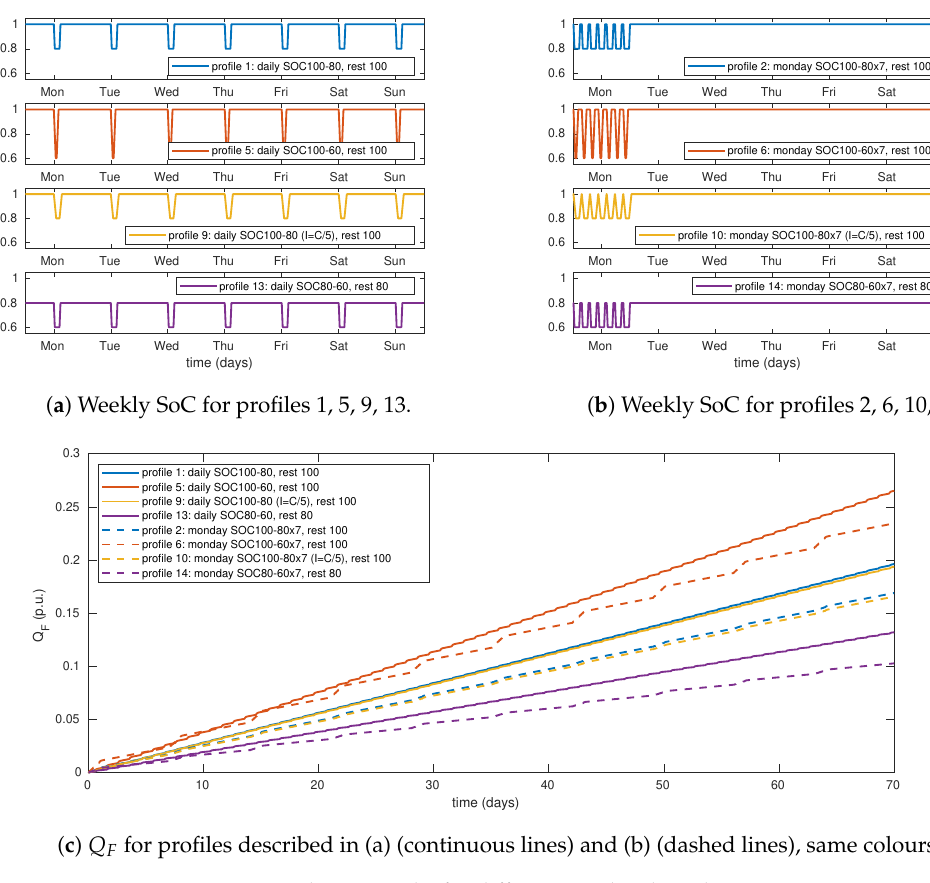
Figure 7. Simulation results for different SoC levels and current